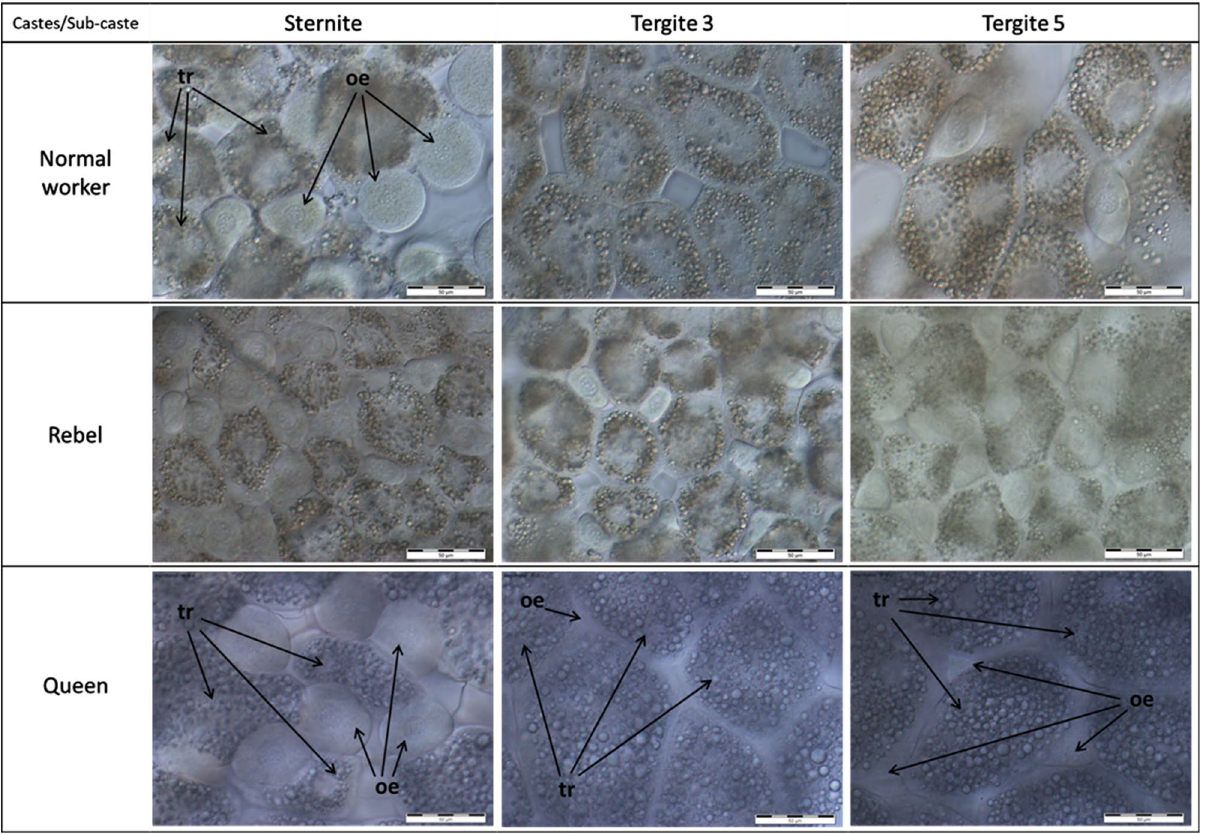
Figure 1. Histological features of fat body cells in Apis mellifera females. The fat bodies were analysed in the sternite and the third and the fifth tergite. Scale bar—50 μm; tr—trophocytes; oe—oenocytes; Tergite 3—the third tergite; Tergite 5—the fifth